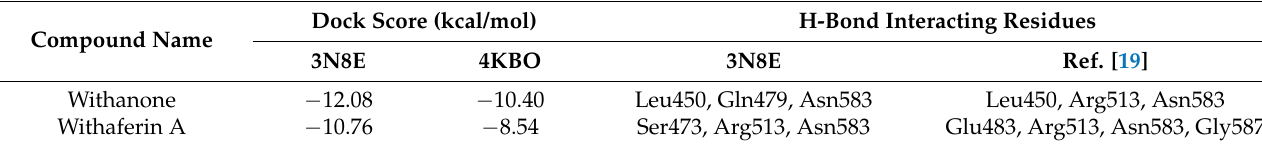
Table 1. Binding energies of reference inhibitors to mortalin models 3N8E and 4KBO.